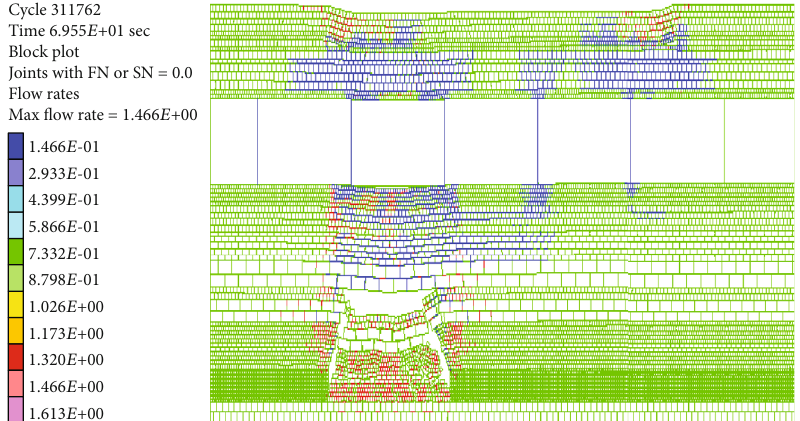
Figure 5: The fl ow distribution in initial caving of #1 key